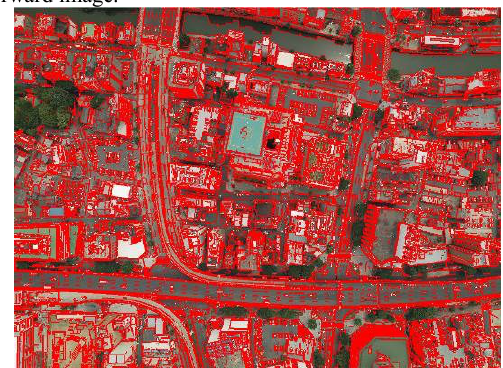
Figure 16. Matching result